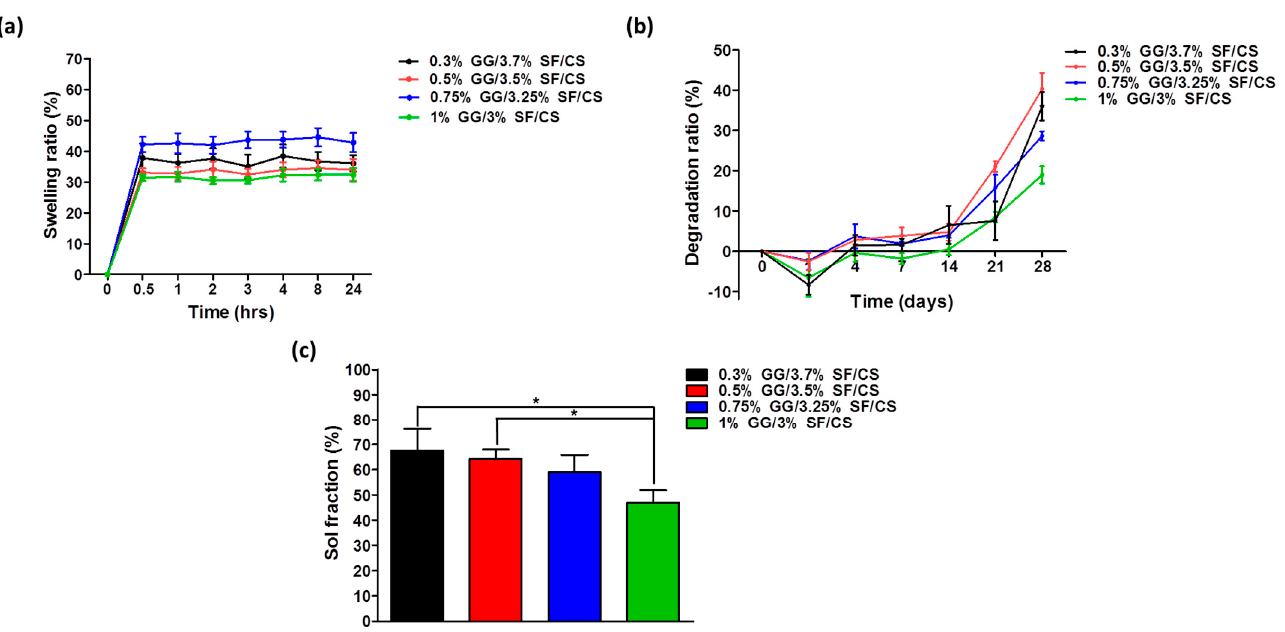
Figure 3. Physicochemical study of the hydrogels: ( a ) swelling ratio (%), ( b ) degradation ratio analyzed for 28 days, and ( c ) sol fraction ratio (%) (values are mean ± SD, n = 6, p < 0.05 (*)).